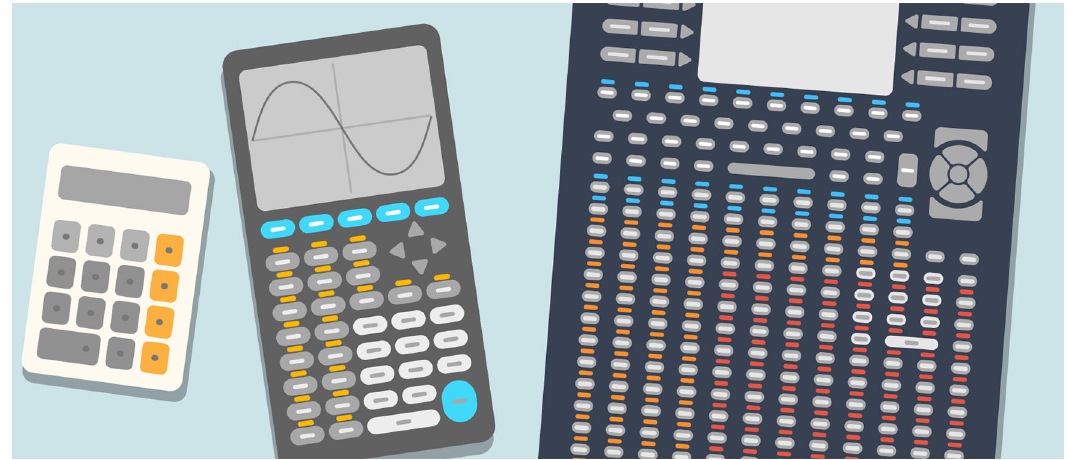
Figure1. Risa smartversionofcalculators. Likethetraditionalhand-held calculators,Risadevicefor quantitative computations. However,R supports amyriad of quantitative operations that are required for modern biosciences. If the order of 100,000 R functions were to be accessed via push button keys, i.e., the same way as traditional calculators — one key per function, the device would be unwieldy. A programming language is a logical way to interact with a “ smart calculator ”